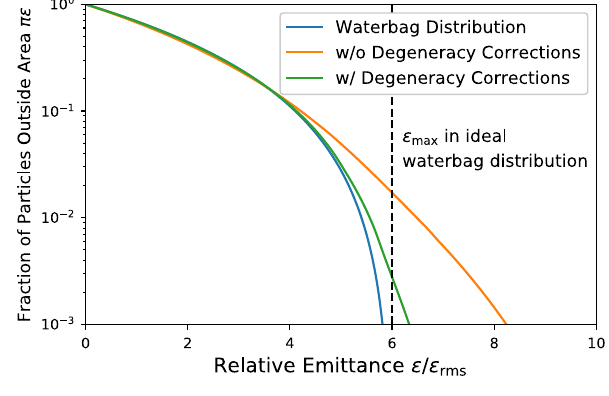
FIG. 10. Fraction of particles that fall outside the ellipse (orientation defined by Twiss parameters) with area πε in each of the three distributions in Fig. 9. The vertical dashed line corresponds to the sharp phase space edge of the waterbag 6 . The blue curve approaches ε = ε 6 distribution at ε = ε rms ¼ rms ¼ if the lower range of the ordinate is